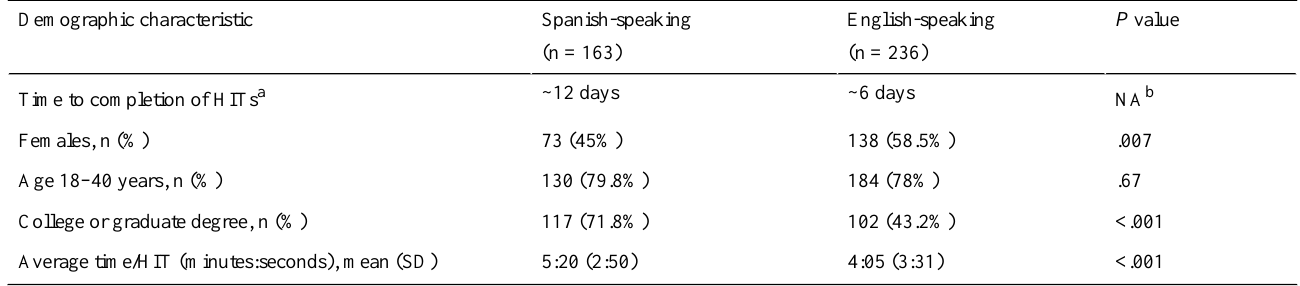
Table 2. Comparison of Spanish-speaking and English-speaking survey participants. 163)Demographic characteristic